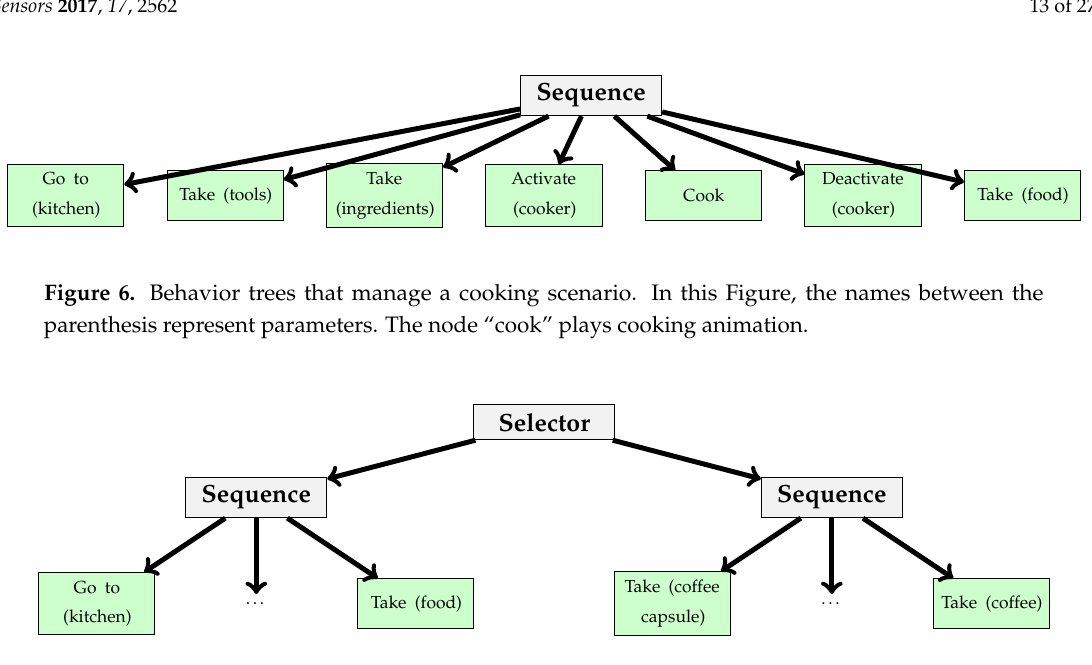
Figure 7. Extension of scenario in Figure 6. In this Figure, the names between the parentheses represent parameters.